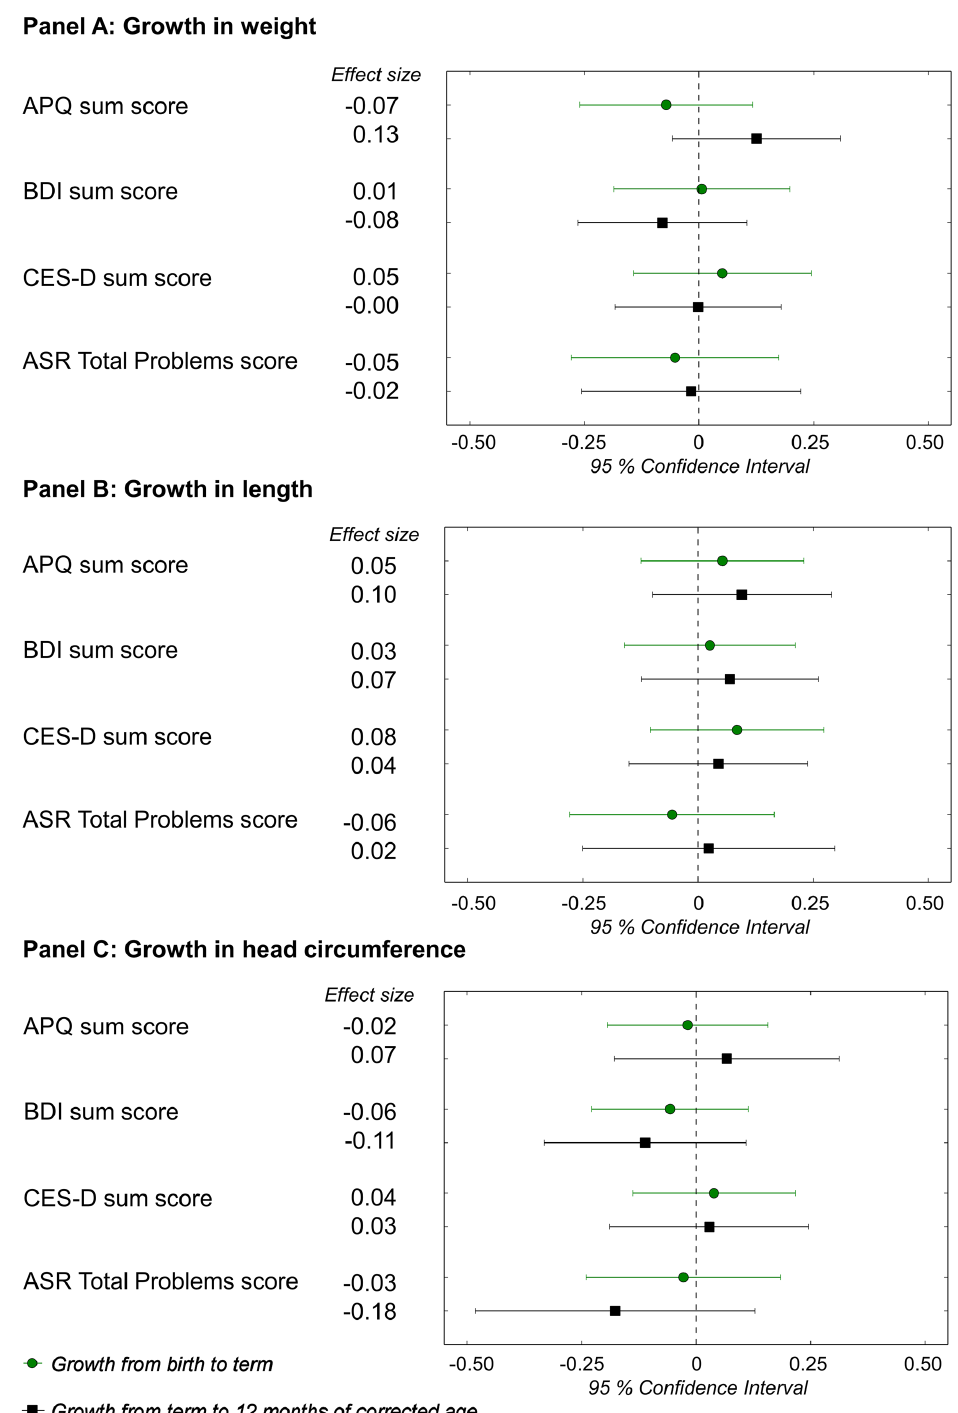
Fig 1. Growth in infancy and mental health questionnaire sumscores in very low birth weight adults. Change in mental health questionnaire sumscores (in SD units) in young adulthood per one SD faster growth from birth to term, and from term to 12 months of corrected age, in individuals with very low birth weight ( < 1500g). We adjusted for gestational age at birth, sex, age at completing questionnaire, highest education of a parent, and time period between closest true measurement point and term (and 12 months CA, when analyzing growth after term). Outcomes were standardized within the study group. Terms and